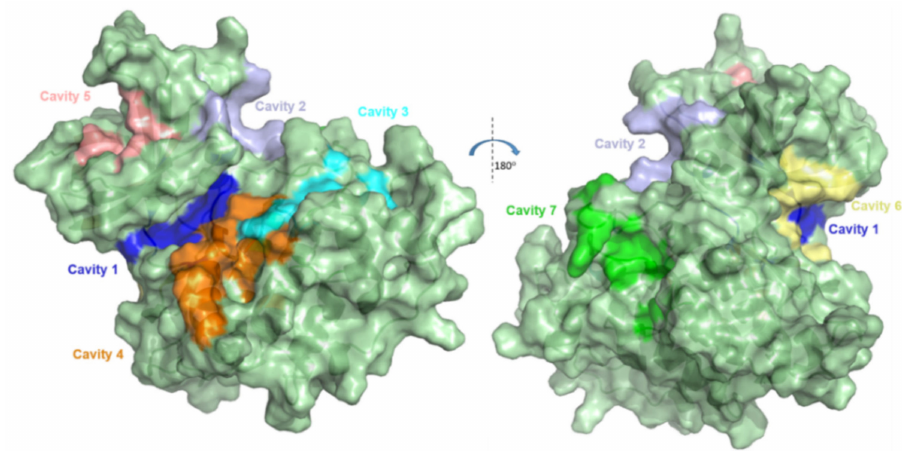
Figure 1. Representation of the 7 cavities/pockets present in GSK-3 β . Image prepared using PDB ID 1PYX in Pymol [22]. Adapted with permission from Palomo et al. J. Med. Chem . 2011 , 54 , 8461–8470 [21]. Copyright 2021 American Chemical Society.